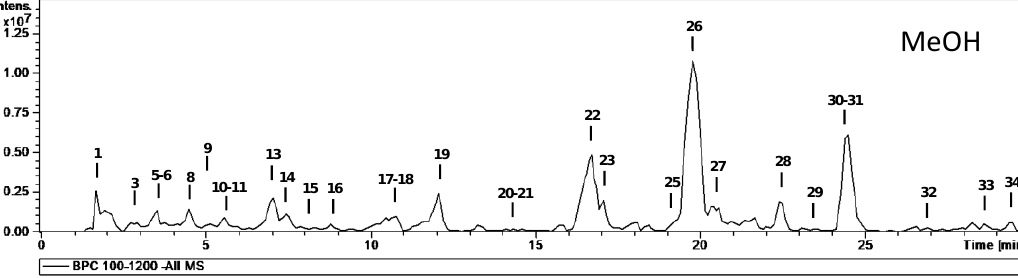
Figure 3. HPLC-ESI-MS n base peak chromatograms of the methanolic extract. Table 3. Quantification of the main phytochemicals in the analyzed extract of T. peltata (mg g −1 dry extract (DE); n = 3).